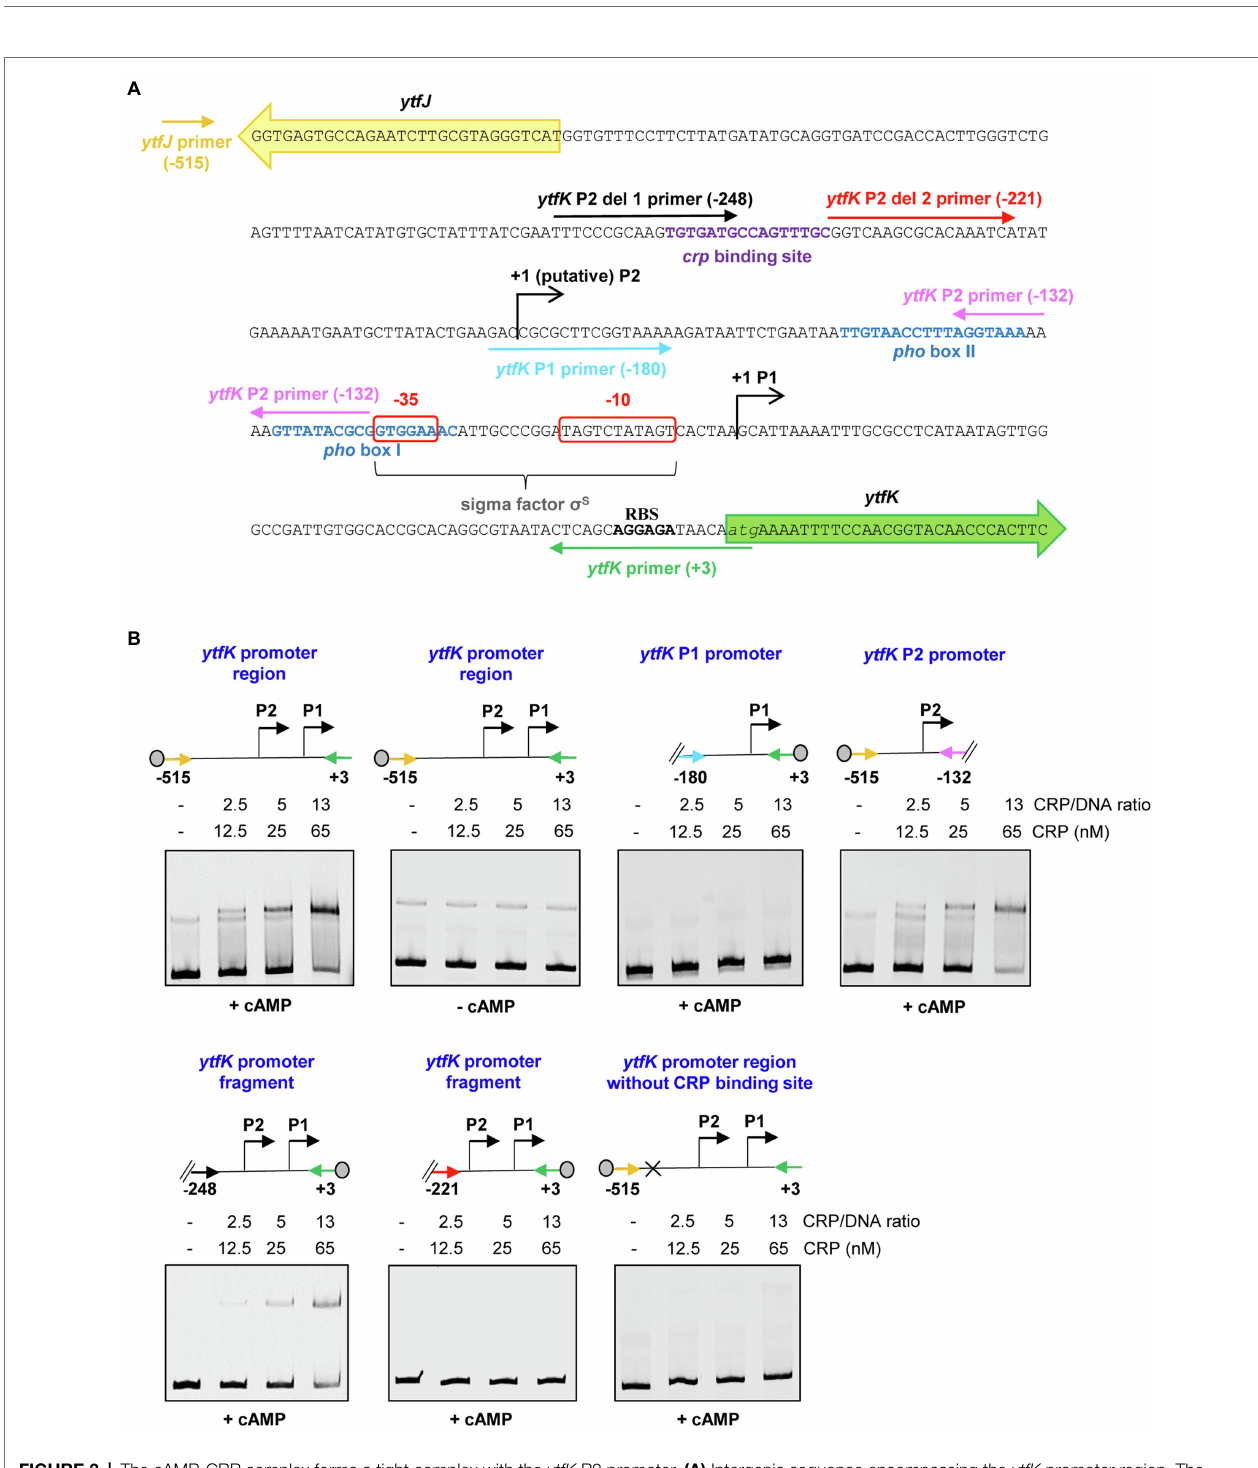
FIGURE 3 | The cAMP-CRP complex forms a tight complex with the ytfK P2 promoter. (A) Intergenic sequence encompassing the ytfK promoter region. The coding sequences of ytfK and ytfJ are shown by green and yellow arrows, respectively. The − 35 and − 10 sequences of the P1 promoter are similar to the consensus sequences recognized by the sigma factor σ S (Lacour and Landini, 2004; Salgado et al., 2013) and are boxed as red. The pho boxes (I and II) and the putative CRP-binding site are written in blue and purple, respectively. The transcriptional start sites of the P1 and putative P2 promoters are indicated by black arrows. The putative ribosome-binding site (RBS) located upstream of the ytfK coding sequence and its start codon is indicated in bold and in italic letters, respectively. Primers used to generate DNA fragments for electrophoretic mobility shift assay are indicated by colored arrows and the relative position to the start codon of ytfK is indicated. (B) EMSA using the CRP protein (0, 12.5, 25 or 65 nM) and the indicated DNA fragments (with relative position to the ATG start codon of ytfK ). Position of the Cy5 dye is represented by a gray circle. Samples were incubated for 15 min at 37 ° C, separated by native 5% PAGE and bands were visualized using phosphoImaging (Typhoon, GE Healthcare). Results are representative of three independent